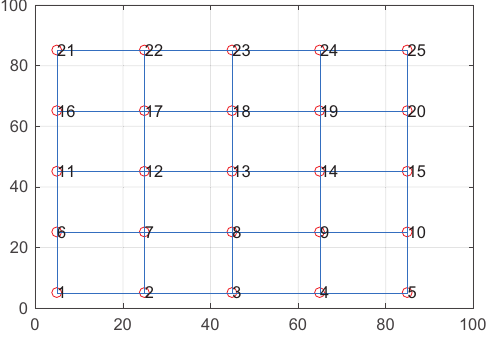
Figure 8. A 5 × 5 grid